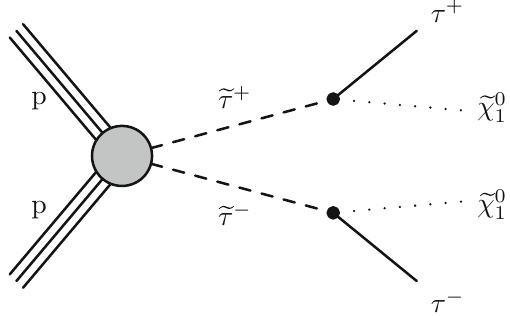
Fig. 1 Diagramfor direct (cid:2) τ pairproduction, followed bydecayofeach (cid:2) τ to a τ lepton and a (cid:2) χ 0